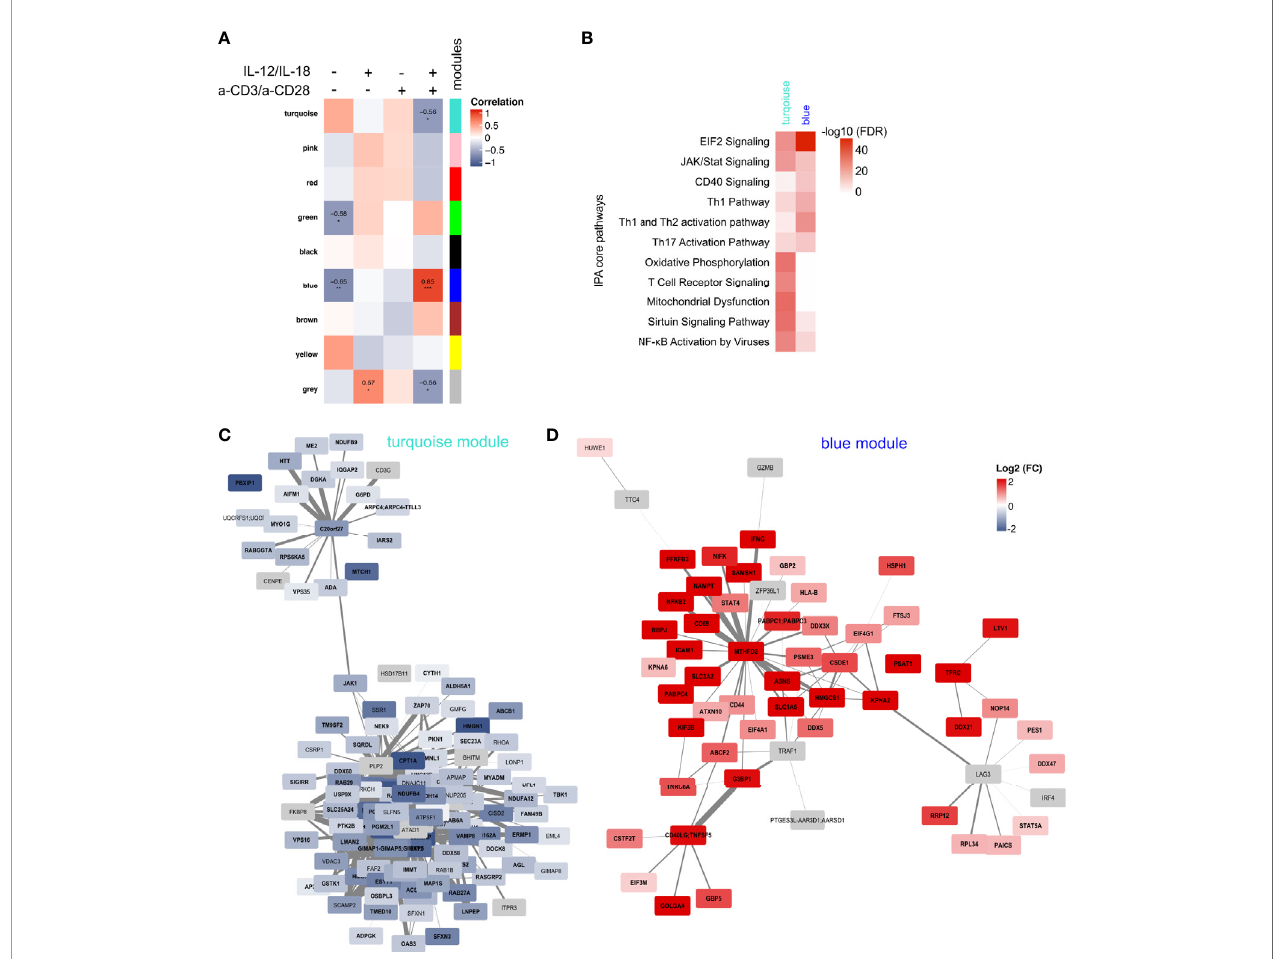
FIGURE 6 | Weighted Gene Correlation Network Analysis of the proteome of activated MAIT cells. (A) Module trait correlation plot showing 25 by color-labeled modules, containing co-abundant proteins, that were correlated to the four treatments. Correlation coef fi cients were added as numbers and corresponding p-values as asterisks with *** ≤ 0.001 ** ≤ 0.01 and * ≤ 0.05. (B) IPA enrichment of proteins from the blue and the turquoise module. Key driver proteins of activated MAIT cells from the modules turquoise (C) and blue (D) with absolute MM and PS ≥ 0.5 and connectivity threshold of ≥ 0.25. Log2(FC) of IL-12/IL-18 + a-CD3/a-CD28-activated MAIT cells compared to unstimulated controls are displayed with signi fi cantly regulated proteins (p-value ≤ 0.05) in bold. Proteins in grey were only quanti fi ed in activated samples, thus Log2(FC) is not